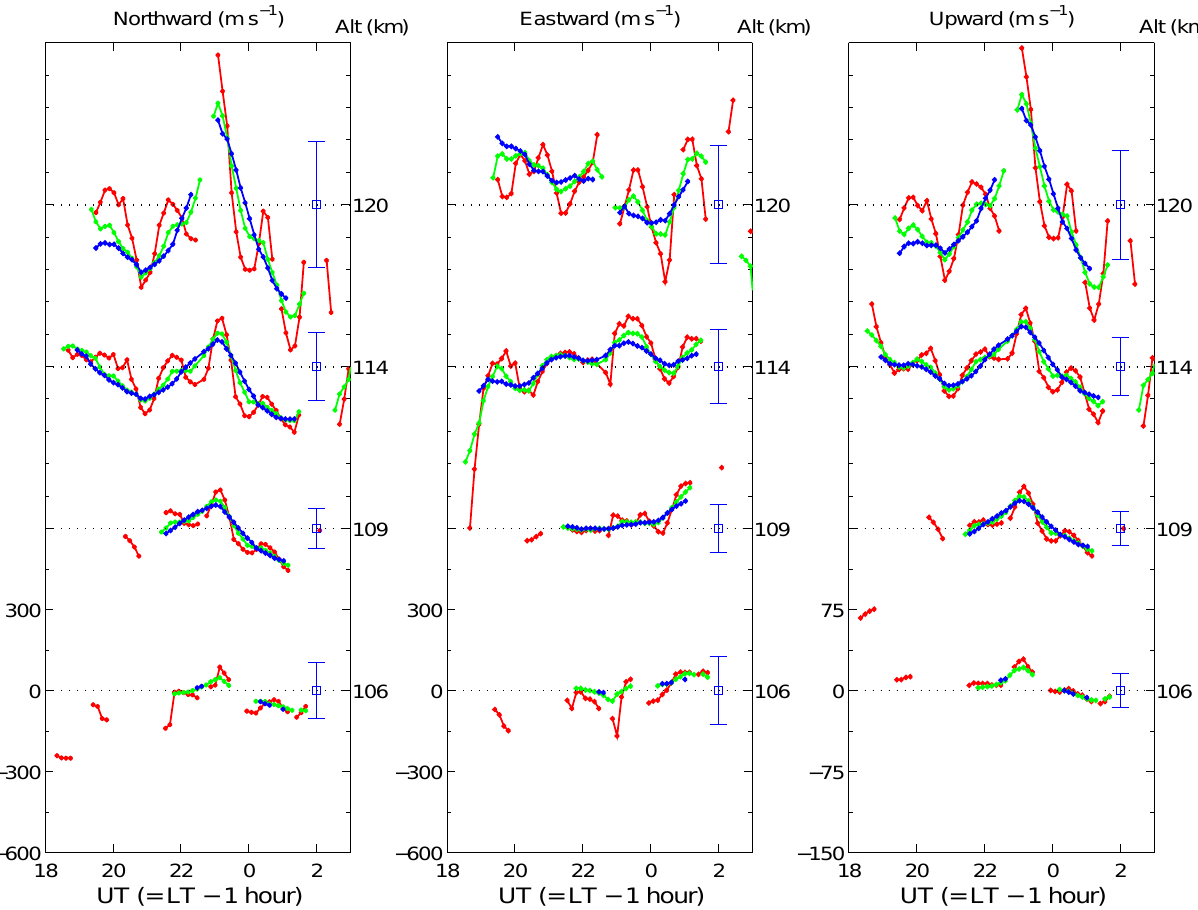
Fig. B2. Temporal variations in northward (left panel), eastward (middle panel), and upward (right panel) components of the neutral-wind velocity calculated using running-averaged data with the 24-, 48-, and 64-min boxcar window lengths (red, green, and blue, respectively). The vertical bars are the mean error for the 64-min case of each component at individual